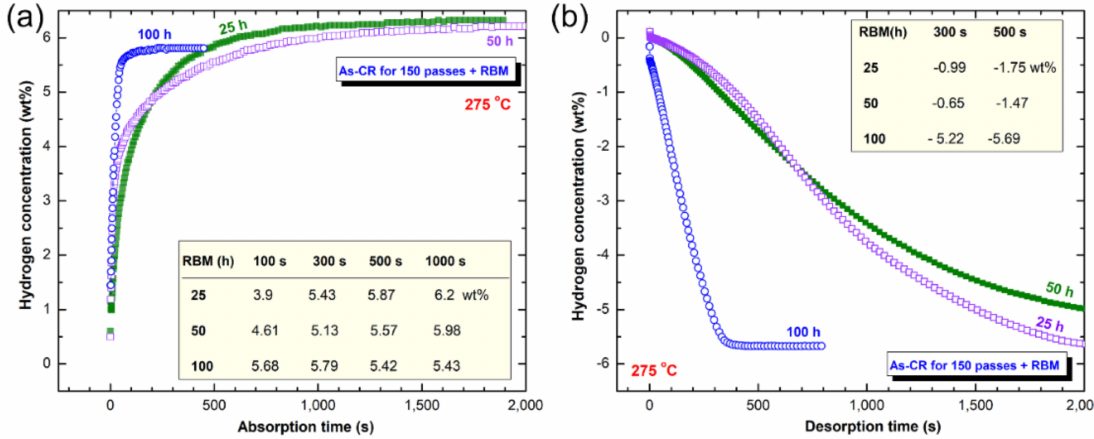
Figure 15. The kinetics of ( a ) hydrogenation, and ( b ) dehydrogenation measured at 275 ◦ C for CR Mg-ribbons obtained after 150 passes, and then RBM for 25, 50, and 100 h. The hydrogenation and consequent dehydrogenation processes were conducted under 10 bar and 400 mbar of H 2 pressure, respectively.